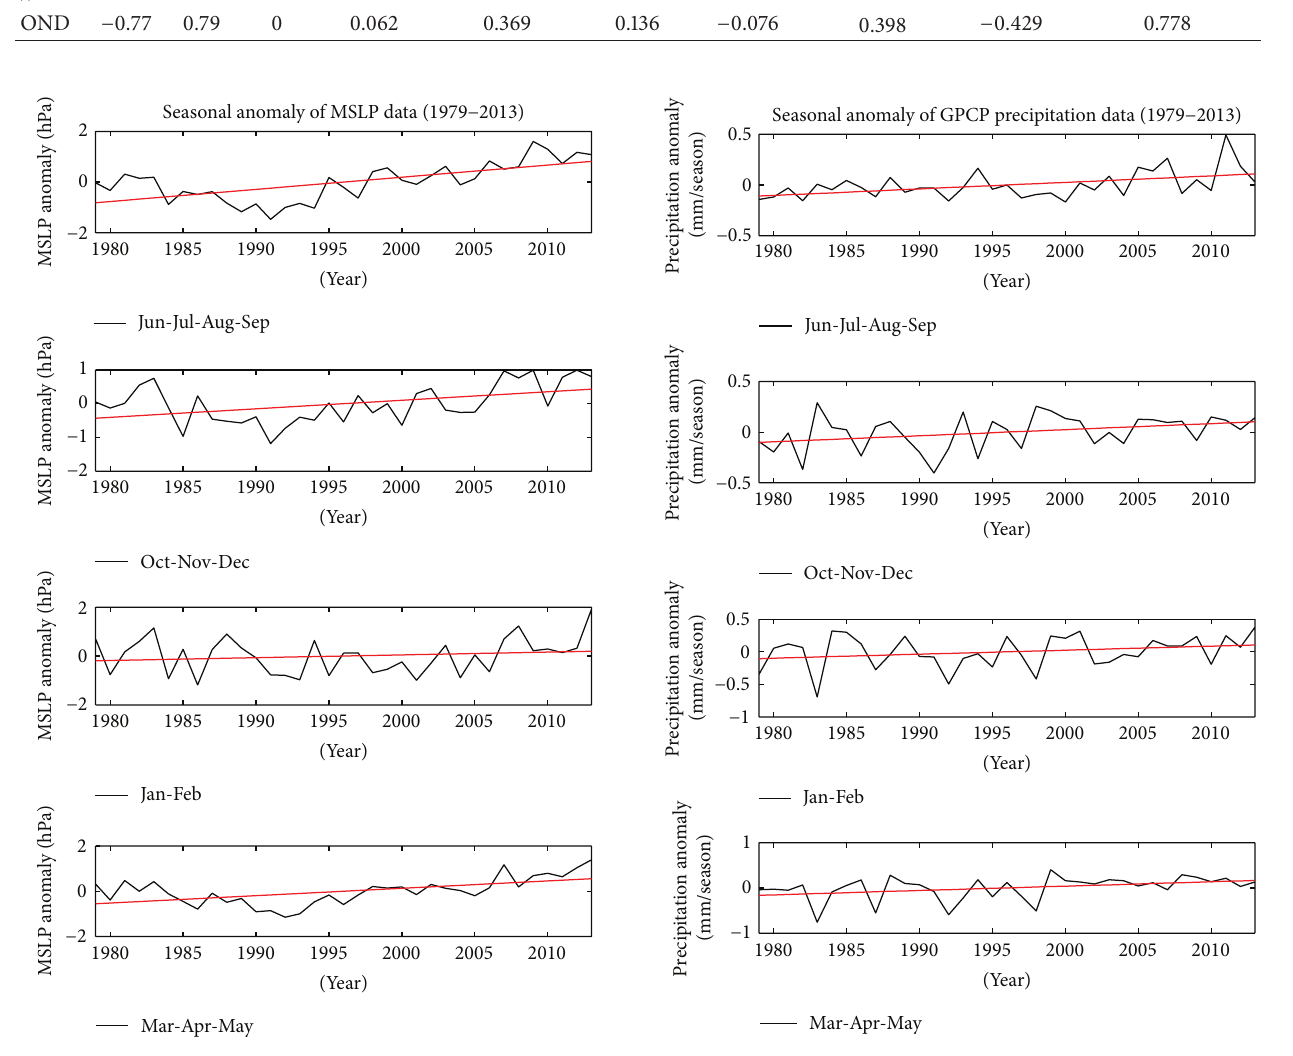
Figure 7: Seasonal anomaly of MSLP. Figure 8: Seasonal anomaly of